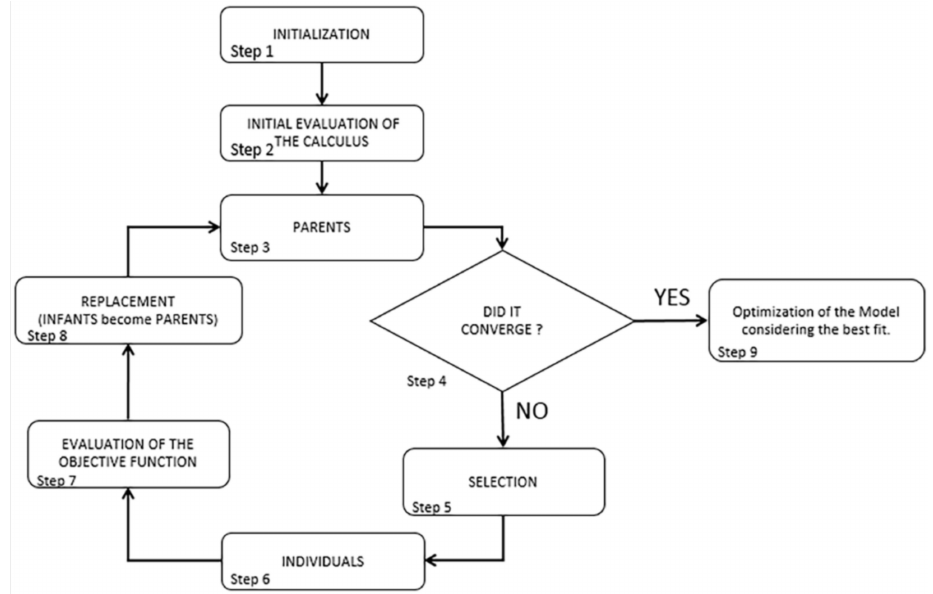
Figure 10. Flowchart representation of the generic